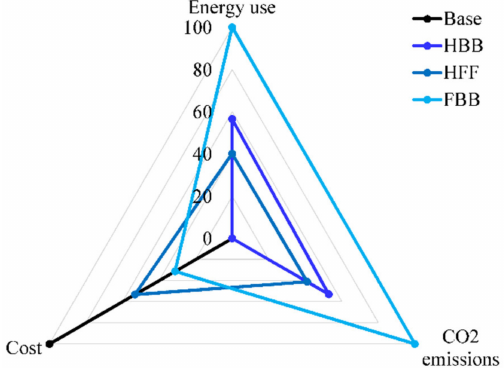
Figure 13. Scenario scores in